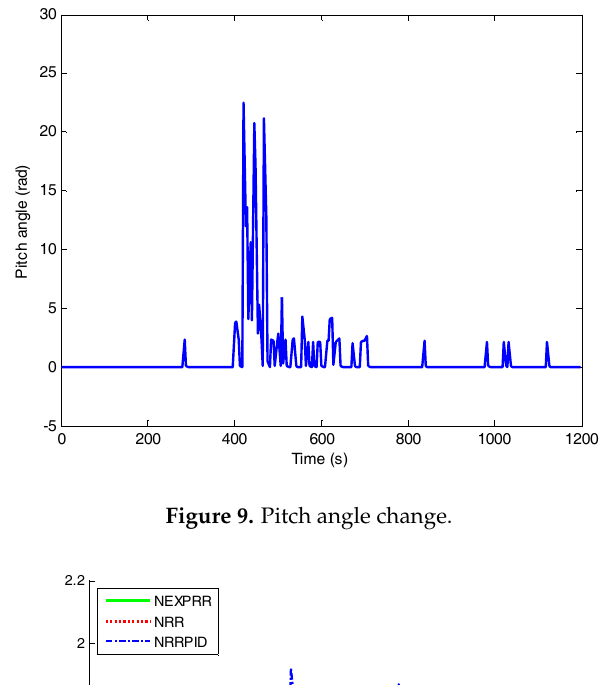
Figure 9. Pitch angle change. Energies 2017 , 10 , 1626